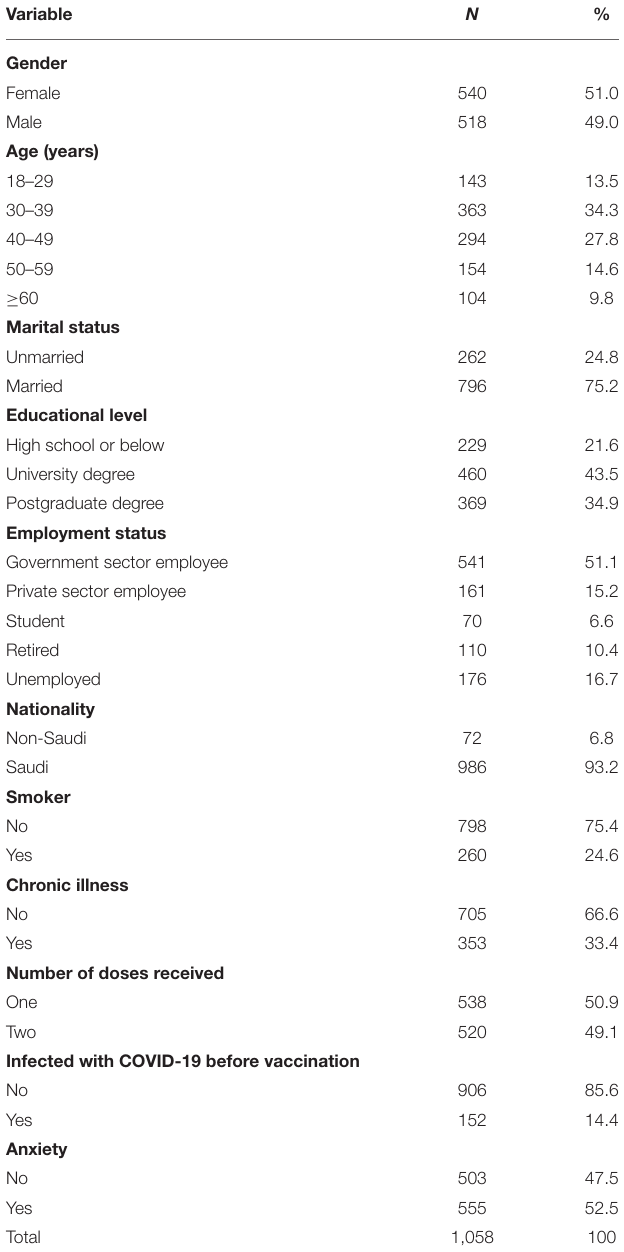
TABLE 2 | Classification of participants involved in the study based on their demographic and health data.